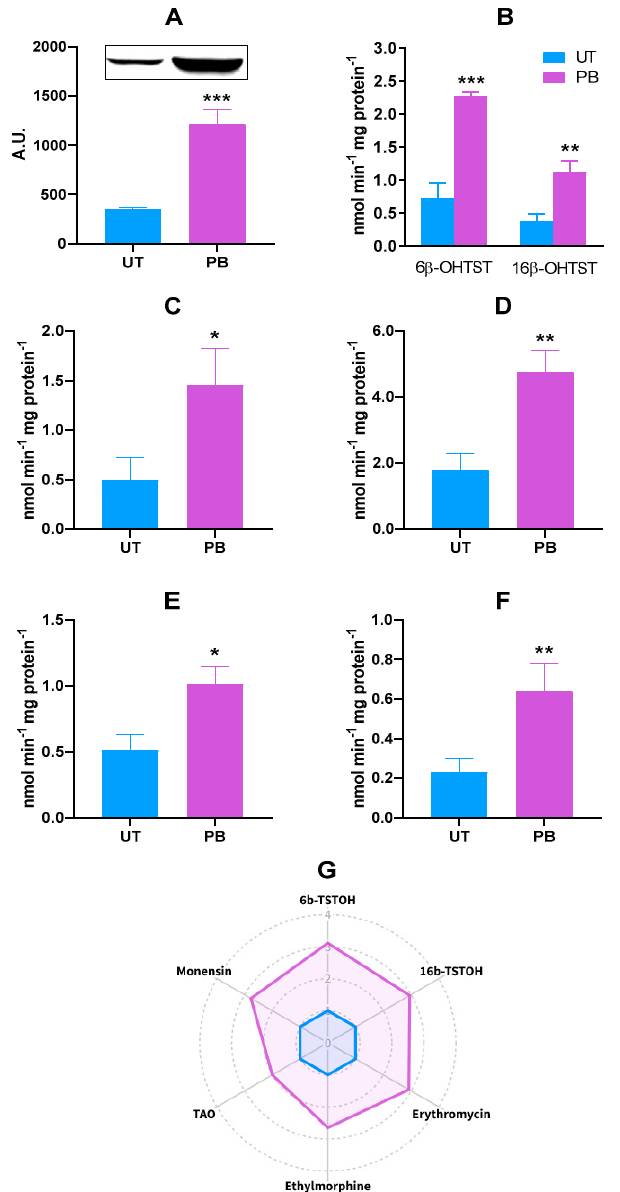
Figure 4. Hepatic CYP3A protein expression ( A ) and in vitro metabolism of CYP3A marker sub- strates TST (6 β - and 16 β -hydoxylation; ( B )), erythromycin ( N -demethylation; ( C )), ethylmorphine ( N -demethylation; ( D )), TAO ( N -demethylation; ( E )), and monensin ( O -demethylation; ( F )) in untreated control (UT, n = 3) and phenobarbital-treated (PB, n = 4) cattle. In the radar plot ( G ), data are expressed in arbitrary units (A.U.), and a value of 1 was attributed to UT cattle. In the bar charts, data are expressed as arithmetic means ± SD. 6b-TSTOH: 6 β -hydroxylated testosterone; 16b-TSTOH: 16 β -hydroxylated testosterone; TAO: triacetyloleandomycin. * p < 0.05; ** p < 0.01; *** p < 0.001 (unpaired t -test).